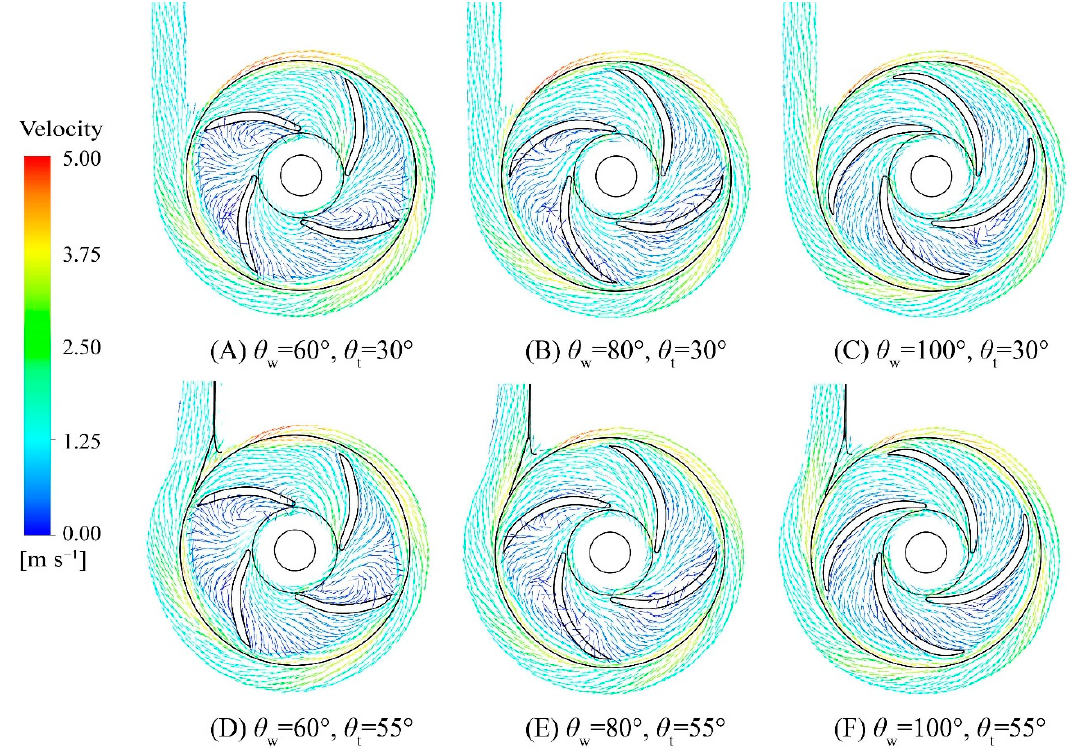
Figure 7. Velocity vectors in the mid-height plane of impeller passage ( z / b 2 = 0.5) of different blade impellers and volutes at the original design point by CFD simulation ( Q 0 = 5.0 L/min, n = 2500 r/min).